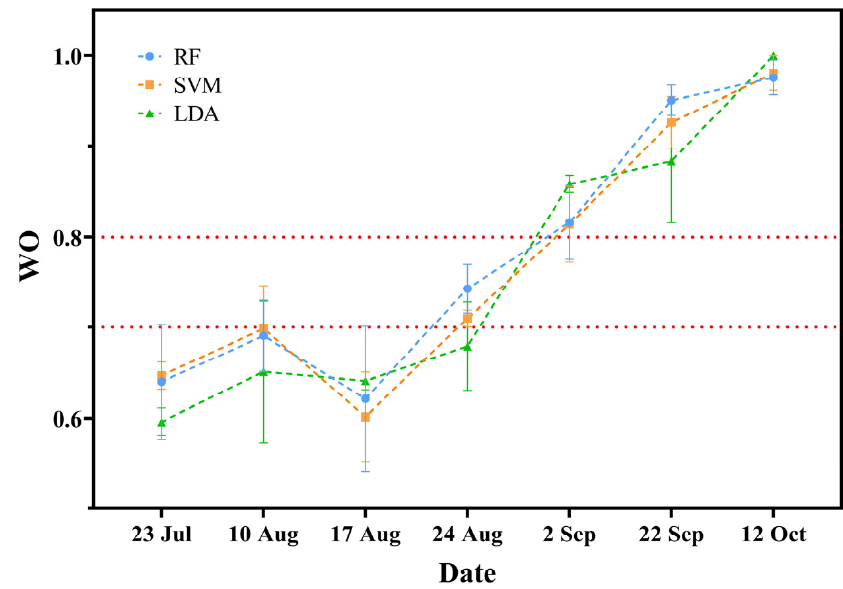
Figure 9. Weighted accuracy of each infection stage. The red dotted line from bottom to top represents 0.7 and 0.8. Table 3. The difference comparison results of the accuracy of the three algorithms under each date.